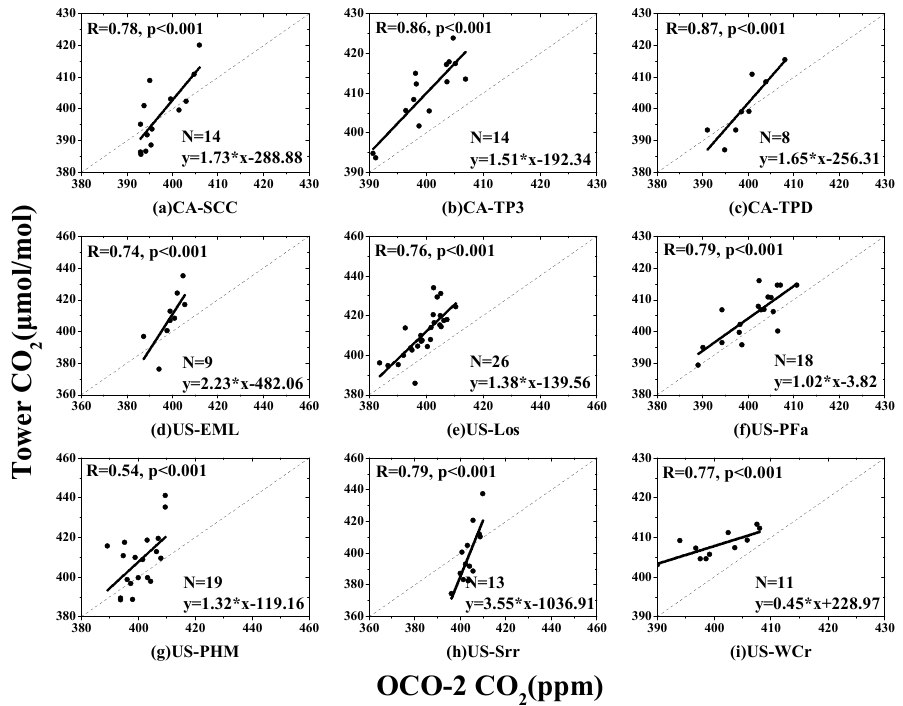
Figure 6. Linear relationships between XCO 2 of OCO-2 and measured surface CO 2 mixing ratio of EC flux towers. Dots indicate CO 2 of EC towers and XCO 2 fit points at the flux towers, and black lines indicate the fit line